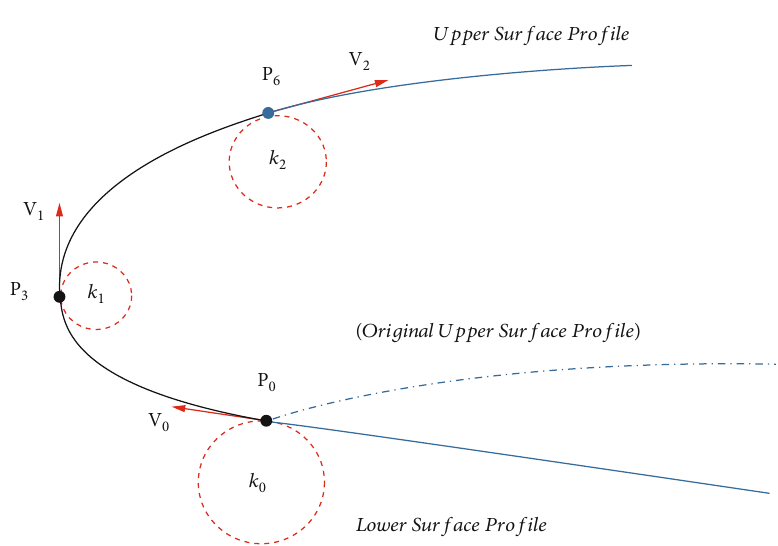
Figure 2: Illustration of interpolation conditions on the blunt